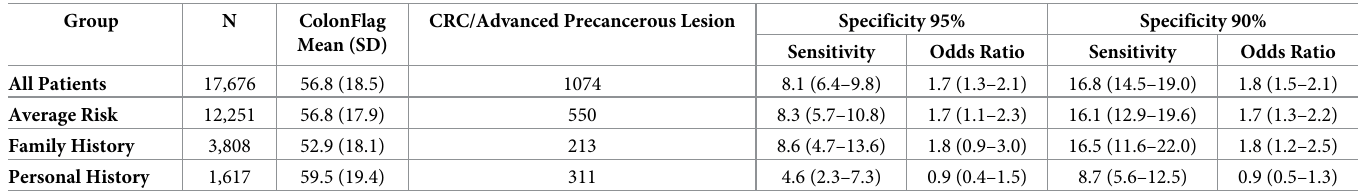
Table 3. Sensitivity and odds ratio of a positive colonflag for colorectal cancer or an advanced precancerous lesion in all study patients, by patient subgroup.